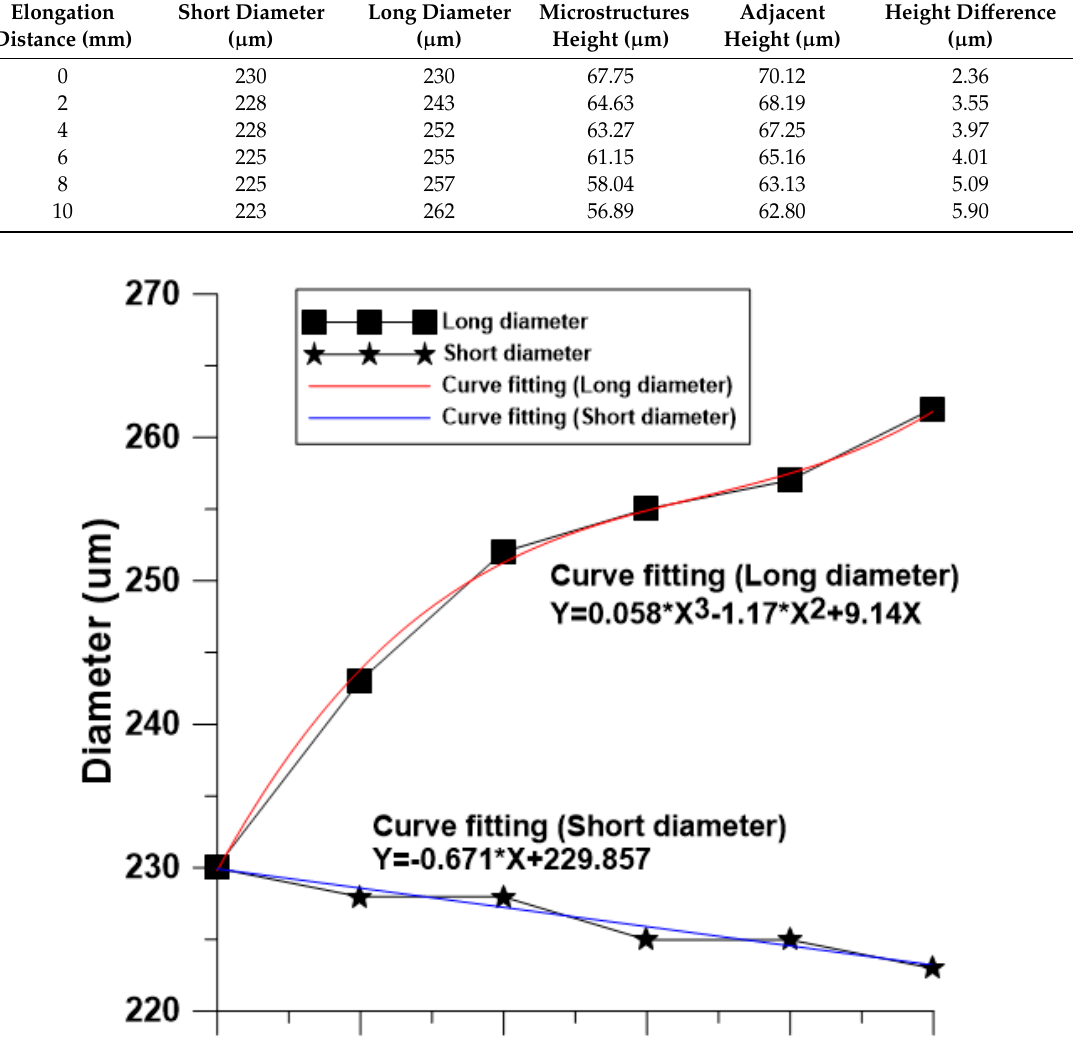
Table 4. Contour features after uniaxial tensile curved imprinting forming.